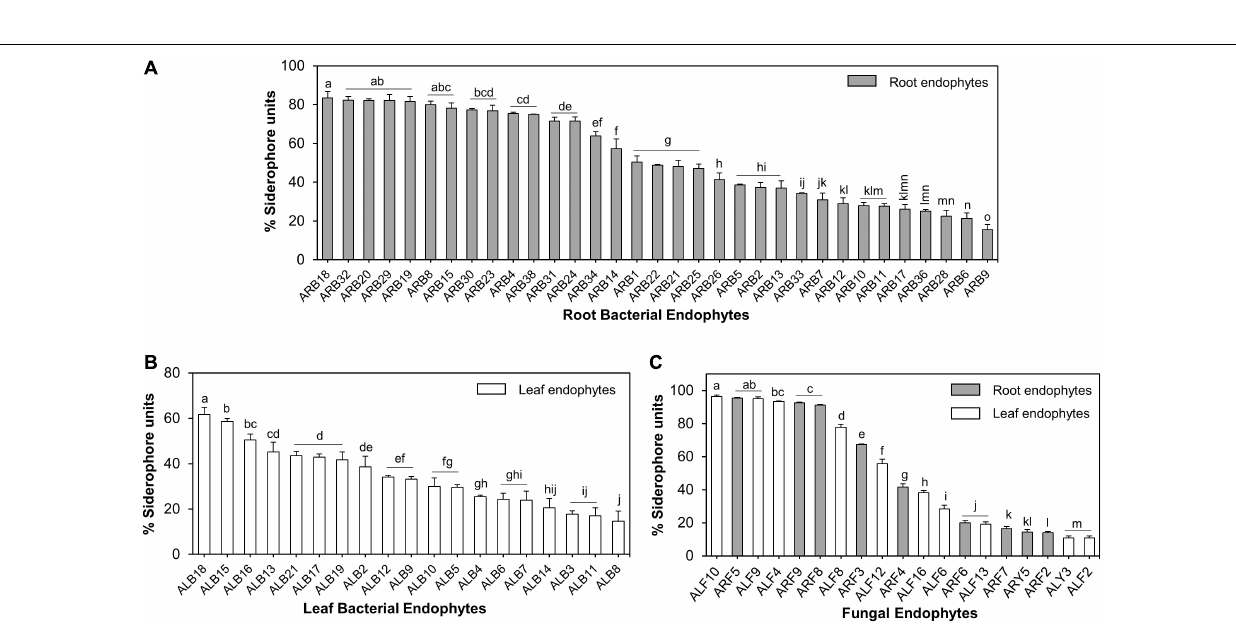
Frontiers in Microbiology |